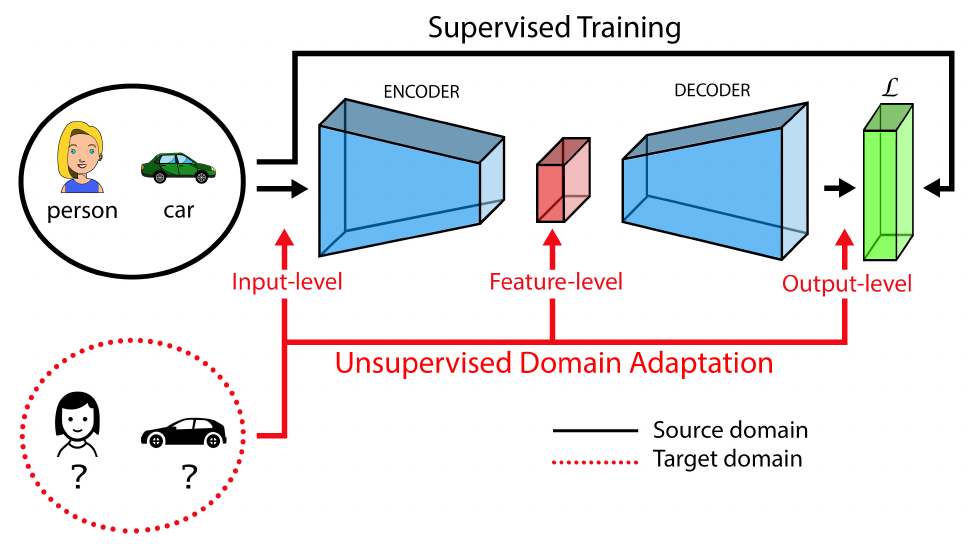
Figure 2. Graphical representation of the unsupervised domain adaptation process. A task-loss L (e.g., a cross-entropy loss) is used for a supervised training stage on the source domain using the semantic annotations. Unsupervised adaptation to target data without labels can be performed at different levels (e.g., input, features or output) with different